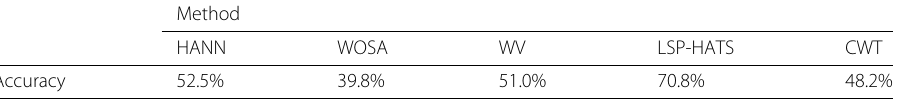
Table 9 Total classification accuracy of the memory encoding EEG signals of one subject, obtained on 10 independent different partition of the